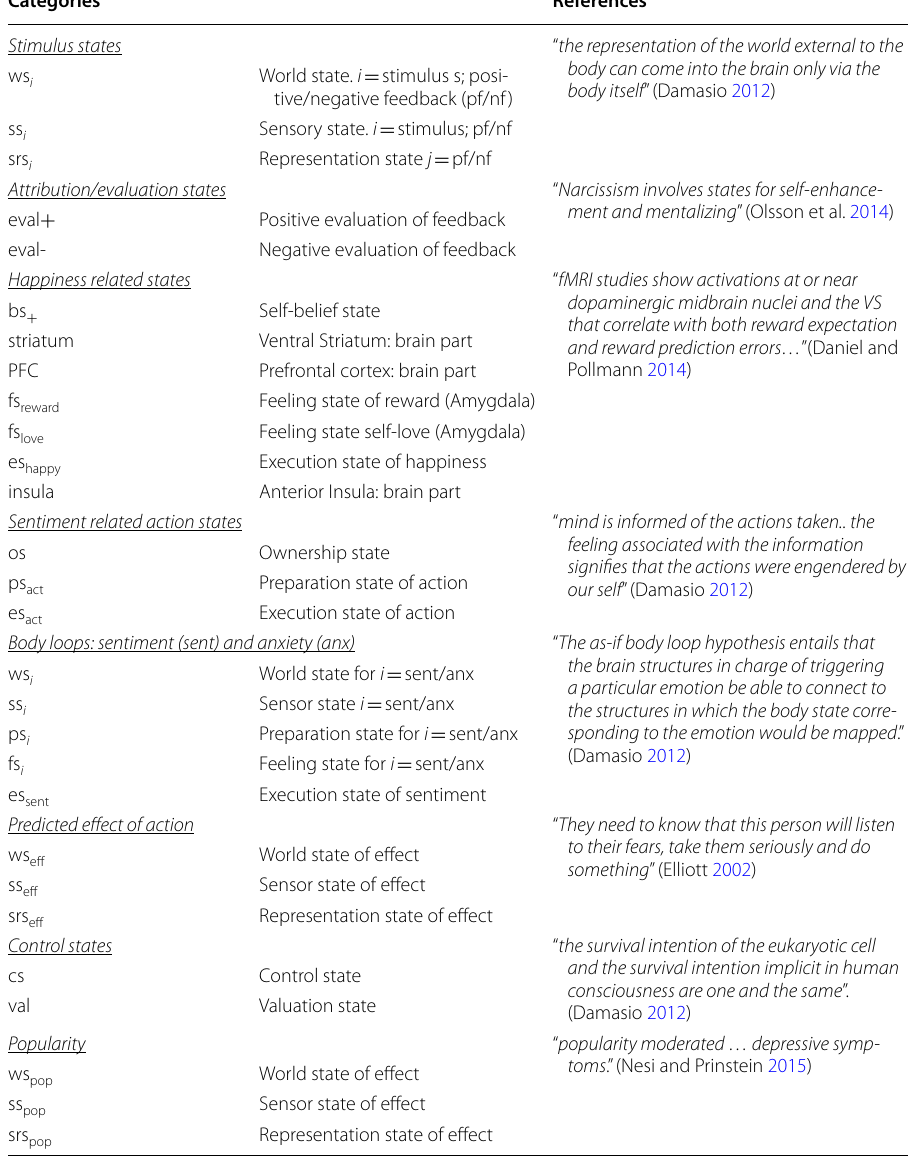
Table 1 Categorical explanation of states of base network (level I)